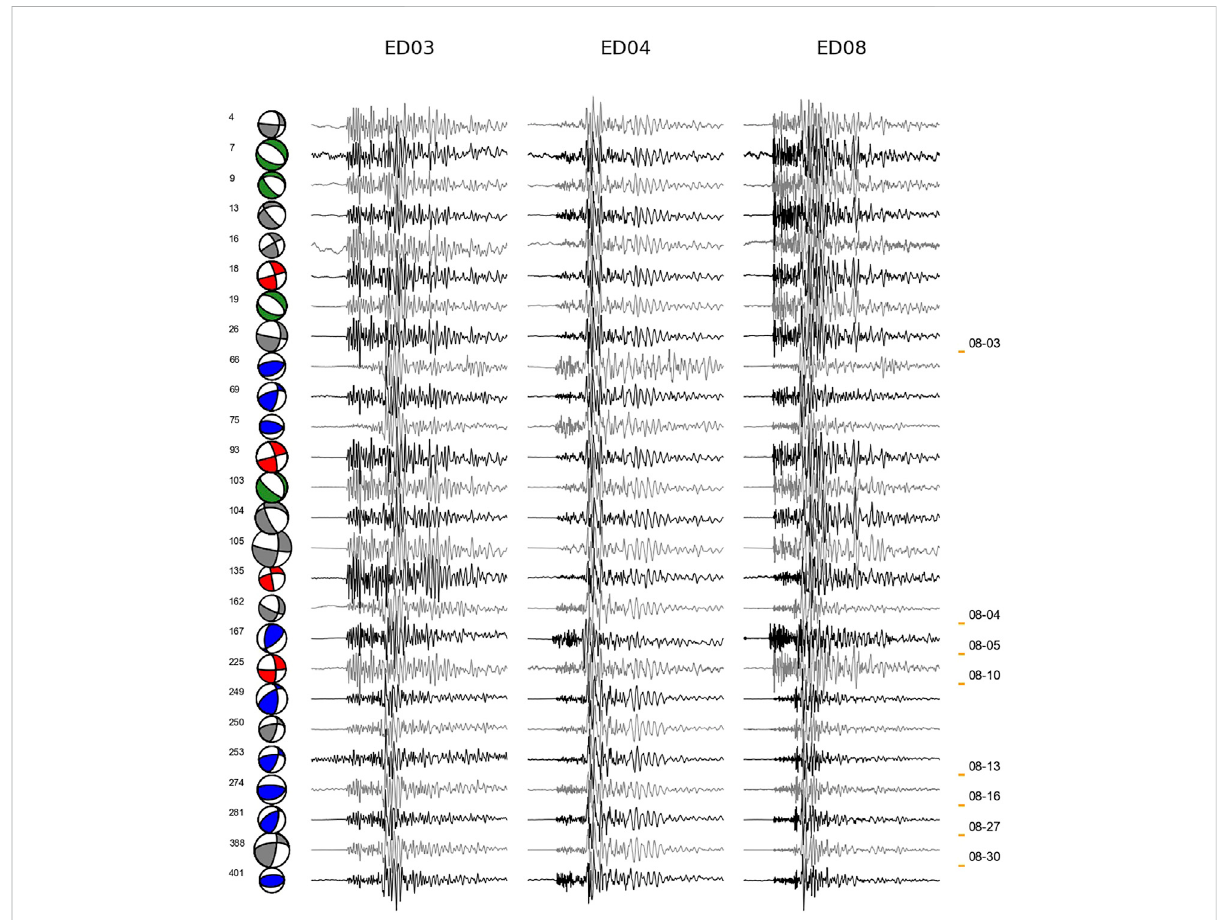
FIGURE 5 Focalmechanisms(ReasenbergandOppenheimer,1985)andselectedwaveformsforthe26best-constrainedearthquakes,i.e.,withmorethan 10 fi rst-pulsepolarities;eventIDsontheleft,labelswithdatesontheright,red,green,blueandgrayrespectivelyforstrike,normal,reverseandmixed solutions. The beach balls are scaled to M W . Aside, the seismograms (vertical component) recorded by three RSC (borehole seismometer) stations, ED03, ED04, and ED08, are plotted for each event (see Figure 3 for stations location). The 8.5 s long signals are not fi ltered, normalized in amplitude, and aligned on P